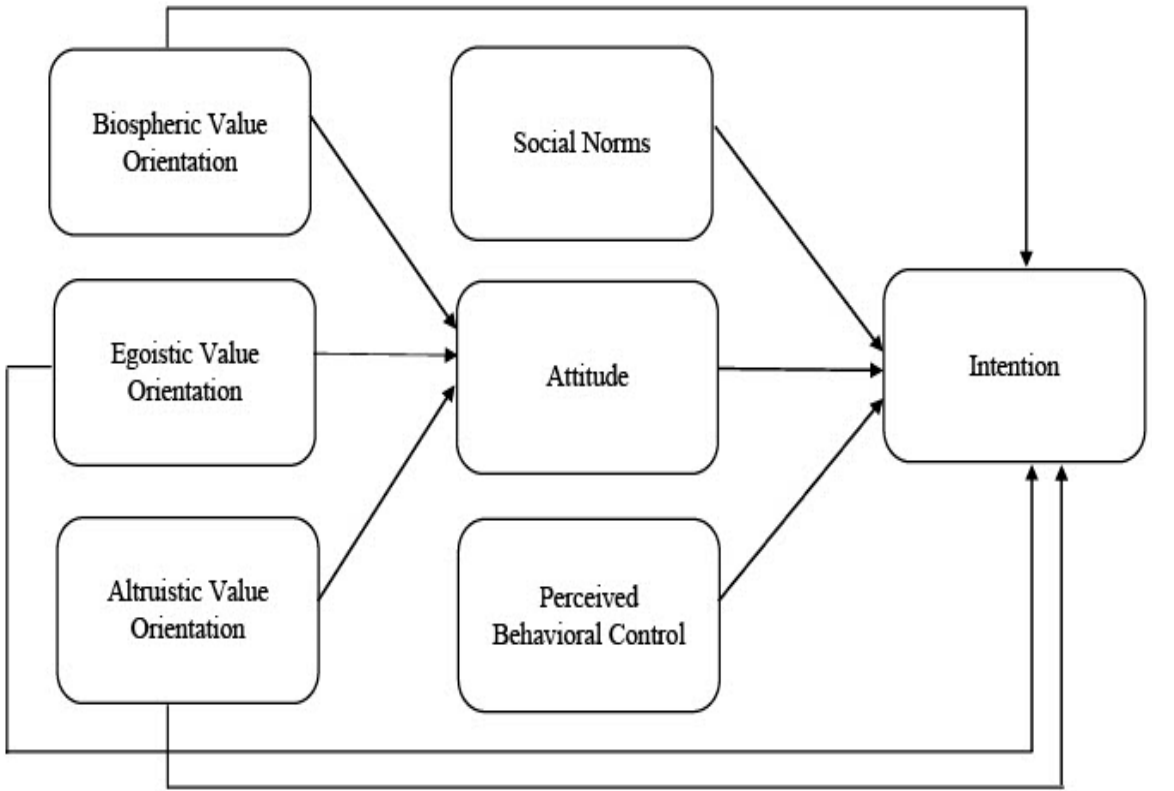
Figure 1. The research model.